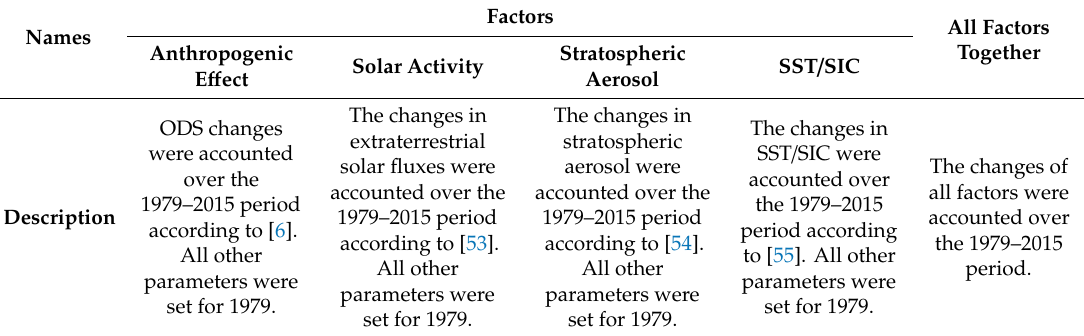
Table 2. The description of the numerical INM-RSHU CCM experiments shown in Figures 5 and